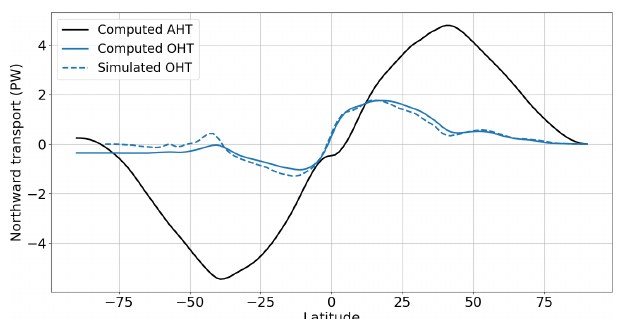
Figure 4. Annual zonal mean northward heat transport (PW) for the pre-industrial period. The northward heat transported computed as residual is represented by a solid line. The atmospheric heat trans- port is in black and the oceanic transport is in blue. The oceanic heat transport simulated by the IPSL-CM6A-LR model is represented by the dashed blue